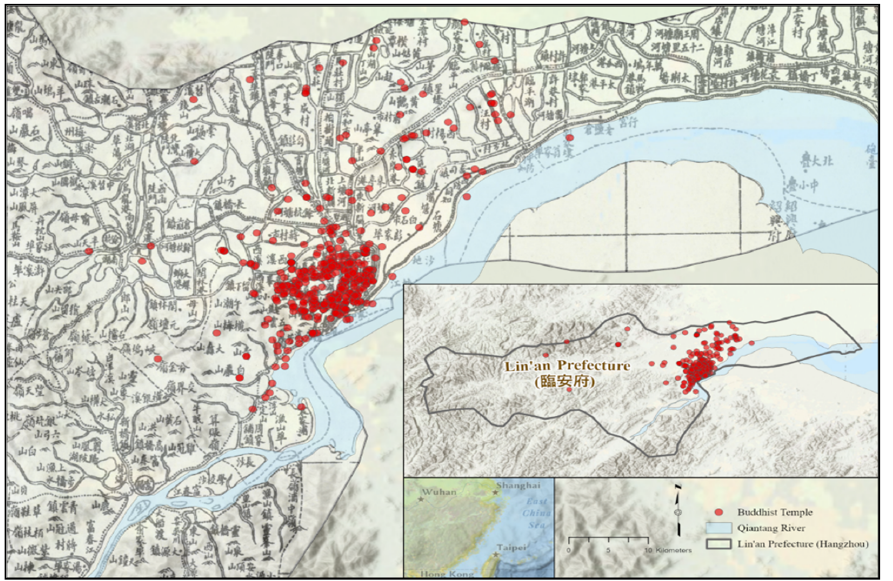
Figure 1. Record of Buddhist temple distribution in the Xianchun Lin’an zhi 咸淳臨安志 ( Records about Lin’an from the Xianchun Reign ).